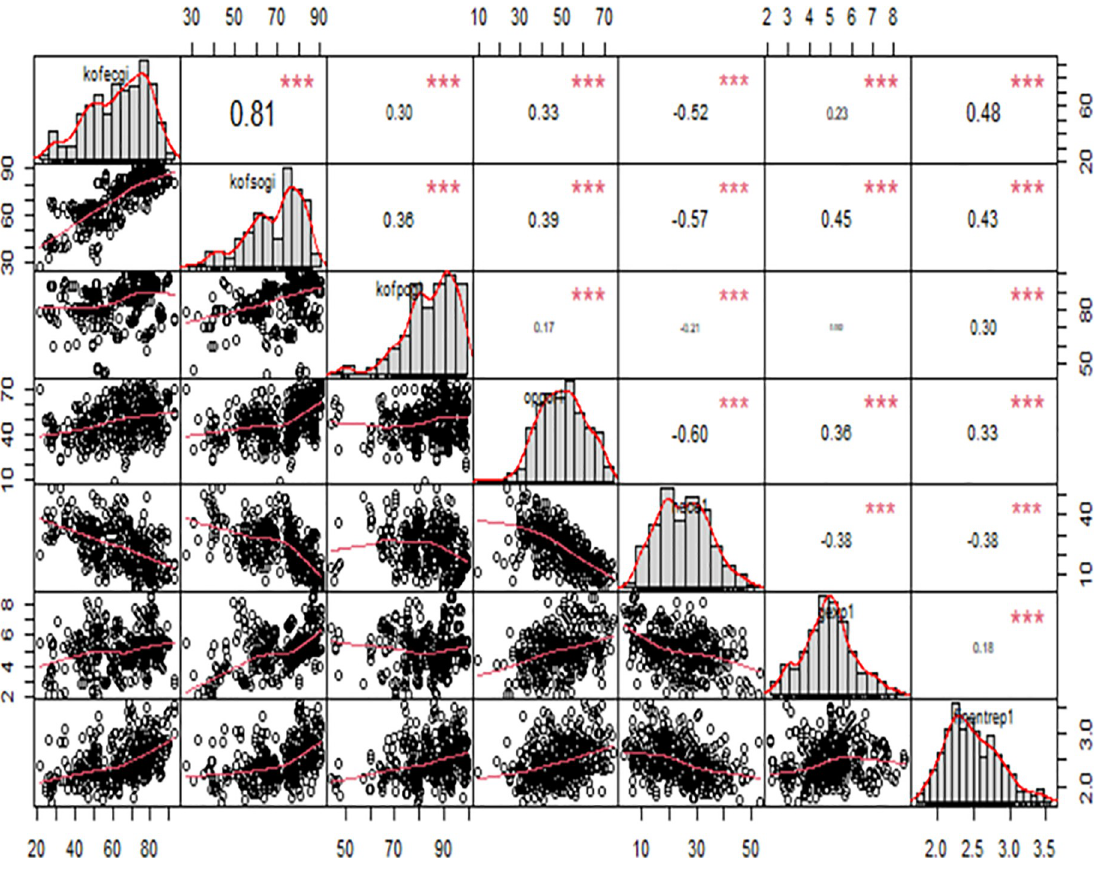
Fig 1. Graphical univariate and multivariate statistics of